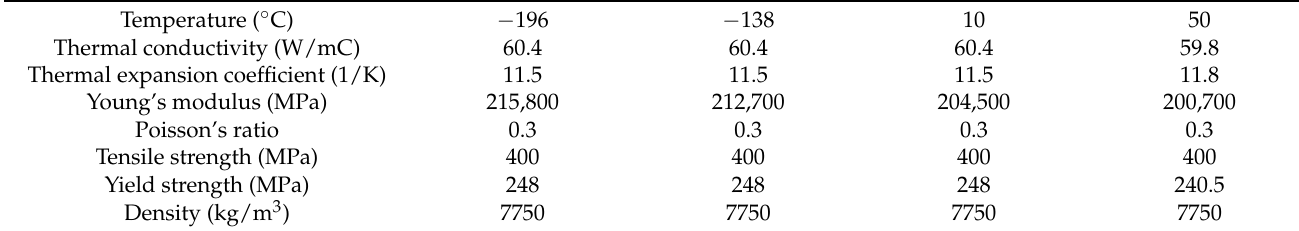
Table 2. Properties of carbon steel